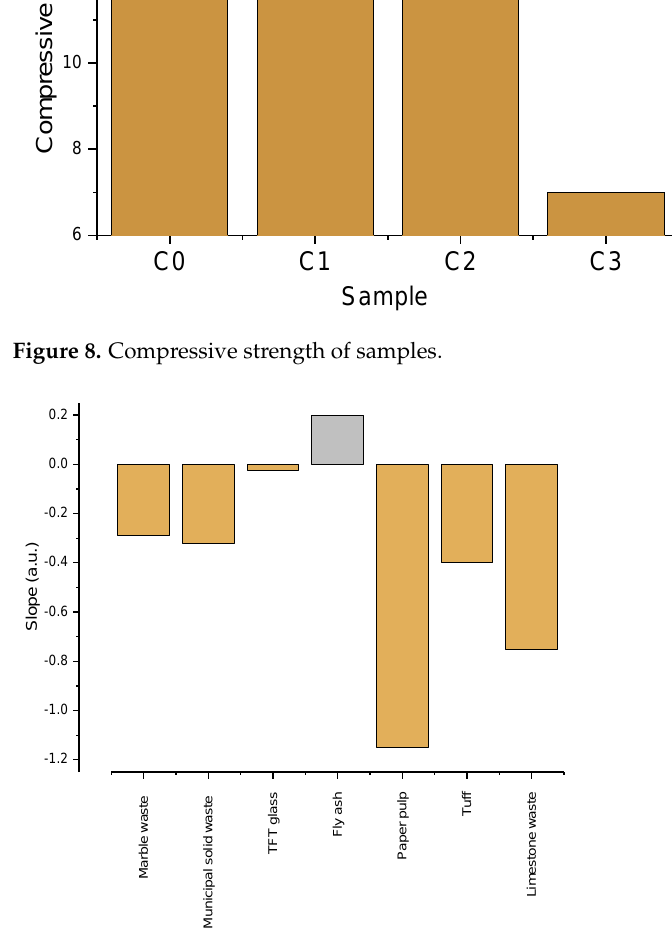
Figure 9. Linear decrease in compressive strength as function of used waste (marble waste [35]; municipal solid waste [36]; TFT glass [37]; fly ash [38]; gypsum waste [39]; tuff [28]; limestone waste—present work).